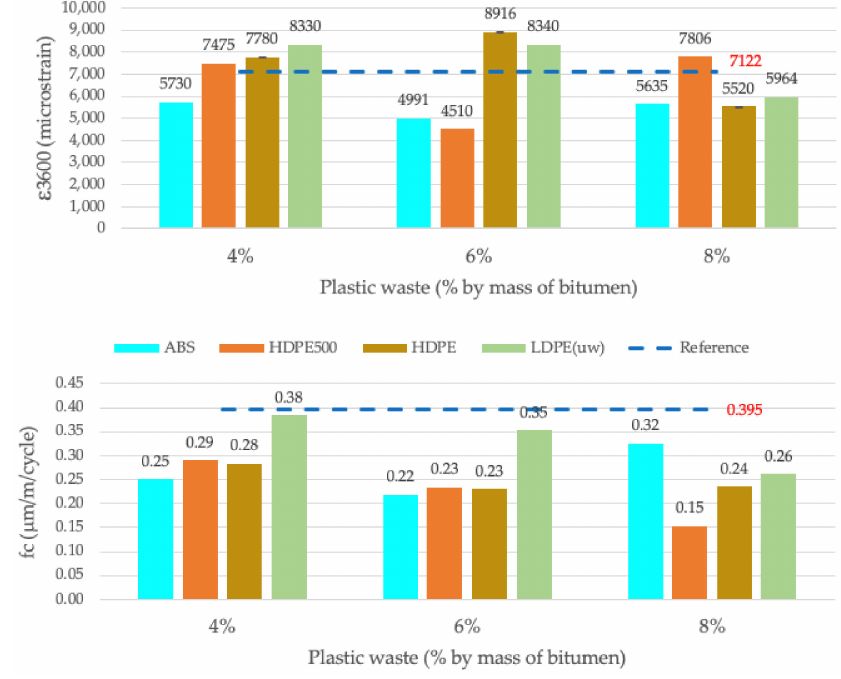
Figure 14. Results for the accumulated strain ( ε 3600) and creep rate ( fc ). Table 2. Permanent deformation resistance ranking derived from cyclic compression tests at 60 ◦